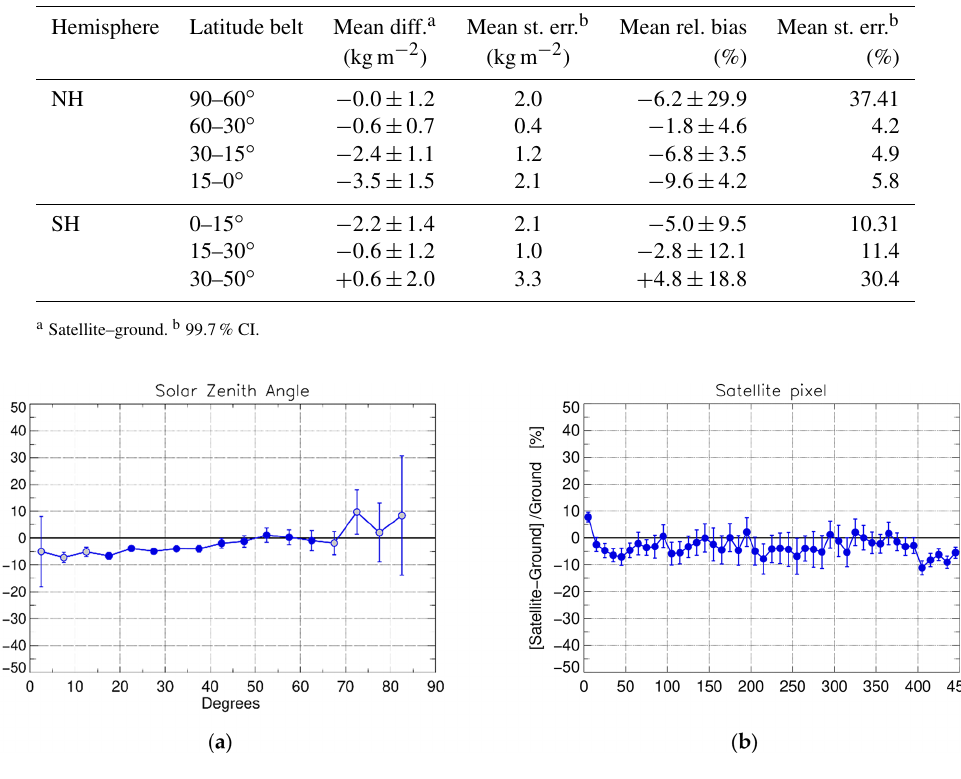
Figure 10. The dependence of the mean relative differences between satellite- and ground-based TCWV observations on solar zenith angle (a) and the satellite pixel number (b) . In both panels, the error bars show the standard error of the mean with a confidence interval (CI) of 99.7%. Grey dots represent bins containing < 3% of the total co-location